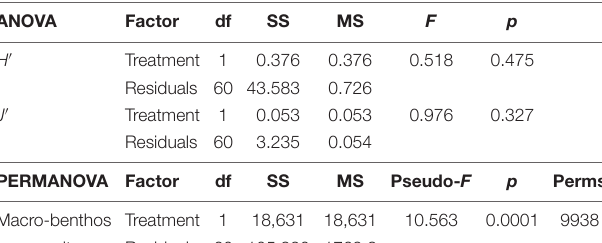
TABLE 1 | One-way ANOVA results of the two diversity indices H (cid:48) (Shannon–Weiner diversity index) and J (cid:48) (Pielou’s evenness) of the two communities, and PERMANOVA result based on the Bray–Curtis similarity matrix of the two communities present in the two treatments (Impact and